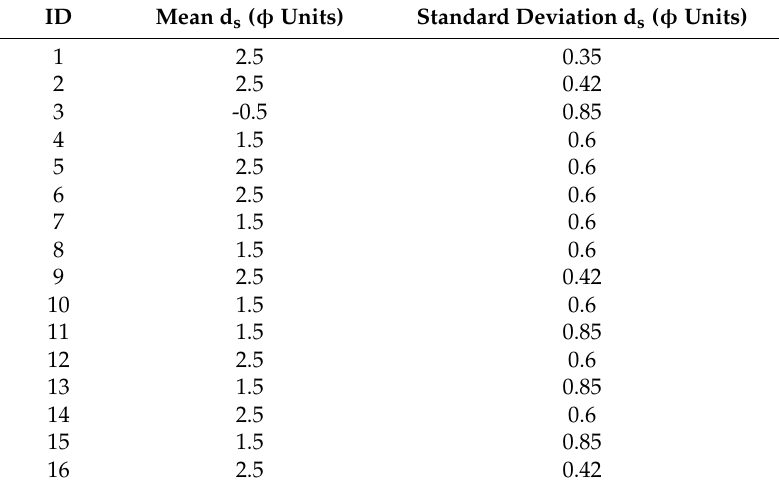
Table 4. Mean sediment diameter and standard deviation sediment diameter of the granulometric distribution of each sample taken along the foreshore nearby the Biferno river mouth, expressed in φ units.